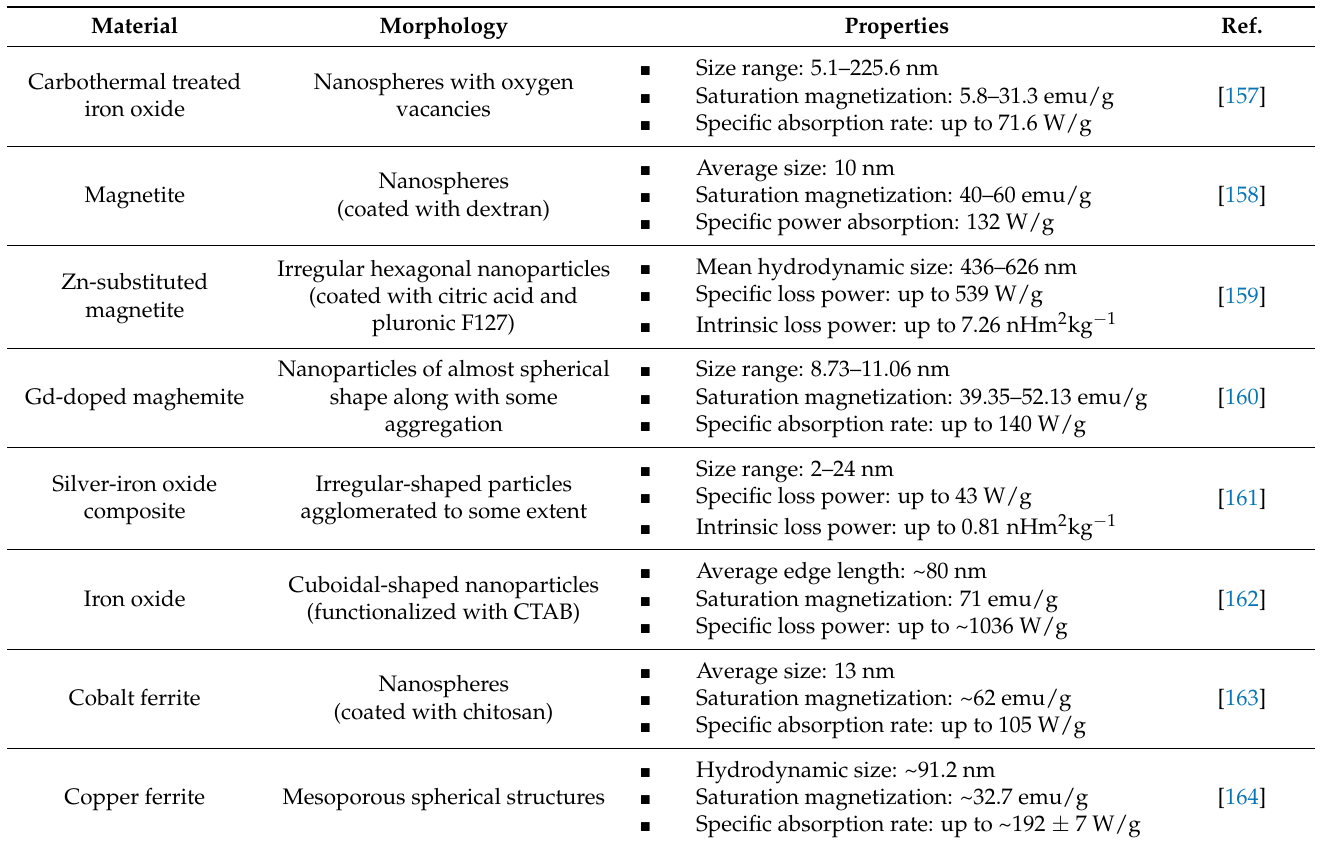
Table 4. Examples of recently developed metal-based nanosystems for application in cancer magnetic